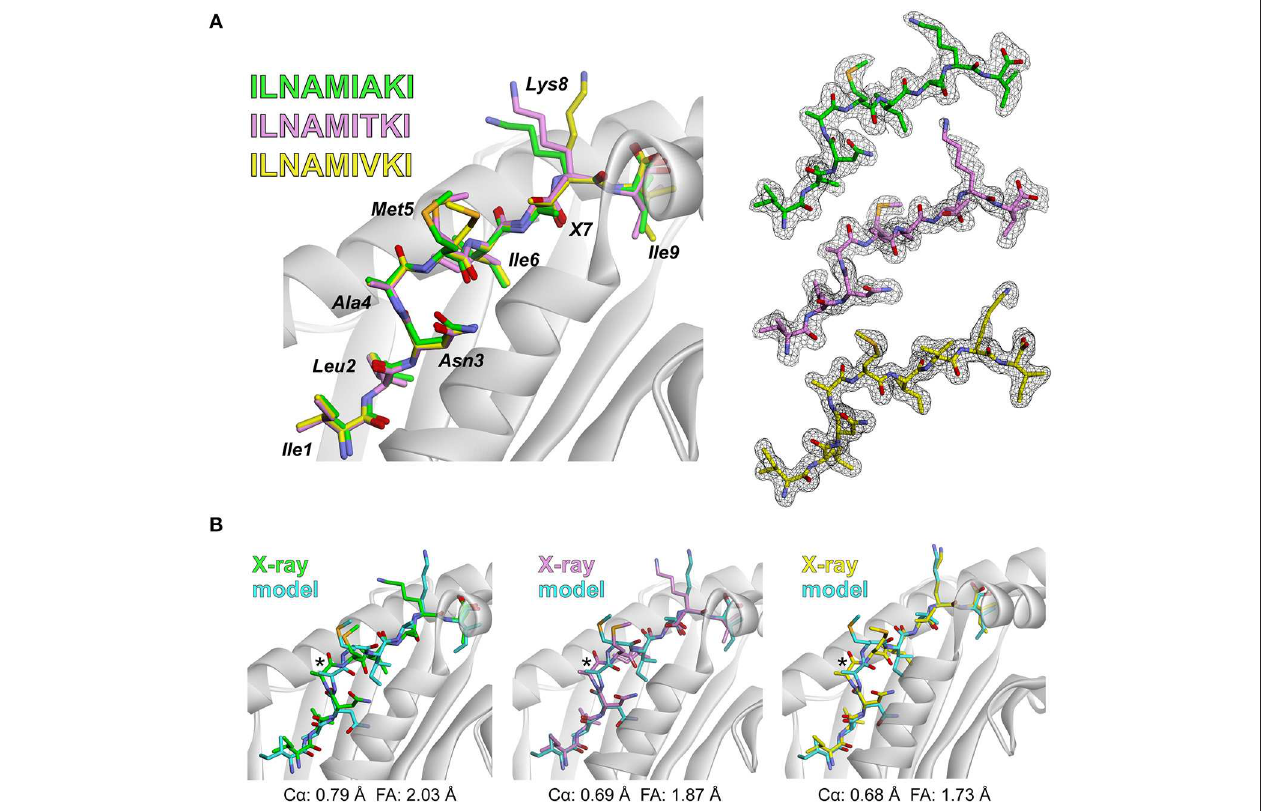
FIGURE 2 | Experimental test of the peptide/MHC modeling strategy. (A) Structures of the ILNAMIAKI, ILNAMITKI, and ILNAMIVKI peptides in the binding groove of HLA-A2 as determined by X-ray crystallography. The peptides are colored green, pink, or yellow as indicated; this color scheme is maintained throughout the figure. The left panel shows all three structures superimposed. Peptide amino acids are indicated, with “X” used to indicate the various amino acids at position 7. The right panel shows 2F o -F c electron density maps contoured at 1 σ for peptides from each peptide/HLA-A2 structure. (B) Comparison of the models of each peptide/HLA-A2 complex with the crystallographic structures. For each panel, the backbone at Ala4 is highlighted with an asterisk and the C α and full atom (FA) RMSD values for each structure/model pair are